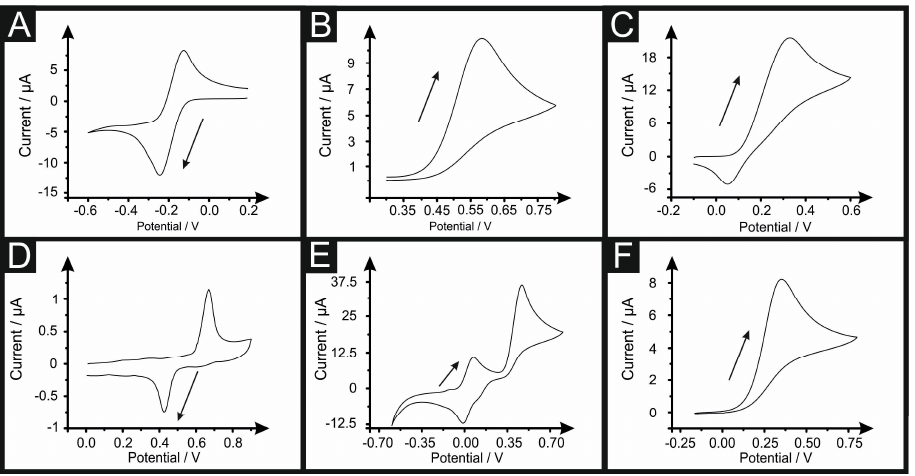
Figure 1. Cyclic voltammetry of 1 mM RuHex ( A ); 1 mM NADH ( B ); 1 mM dopamine ( C ); 1 mM capsaicin ( D ); 1 mM TMPD ( E ) and 1 mM ascorbic acid ( F ) at 0.05 V s − 1 (vs. SCE) and 19.6 ◦ C. The arrow indicates the forward peak selected to calculate the A geo with Equations (2) and (3). Table 1. Calculated electrode areas ( A real ) for SPEs using the Randles–Šev ć ik equations (Equation (2) for quasi-reversible processes of RuHex, TMPD, and capsaicin and Equation (3) for irreversible processes such as NADH, dopamine, and ascorbic acid; note that dopamine has anodic and cathodic processes but is termed irreversible because of the relative rates of electron transfer and mass transport [31]; recorded at 19.6 °C for each redox probe, with the diffusion coefficient used in the calculation. The %Real , which is the percentage of A real divided by the A geo , is also presented ( N = 3). Electroactive Probe Electrode Area Randles–Ševćik/cm 2